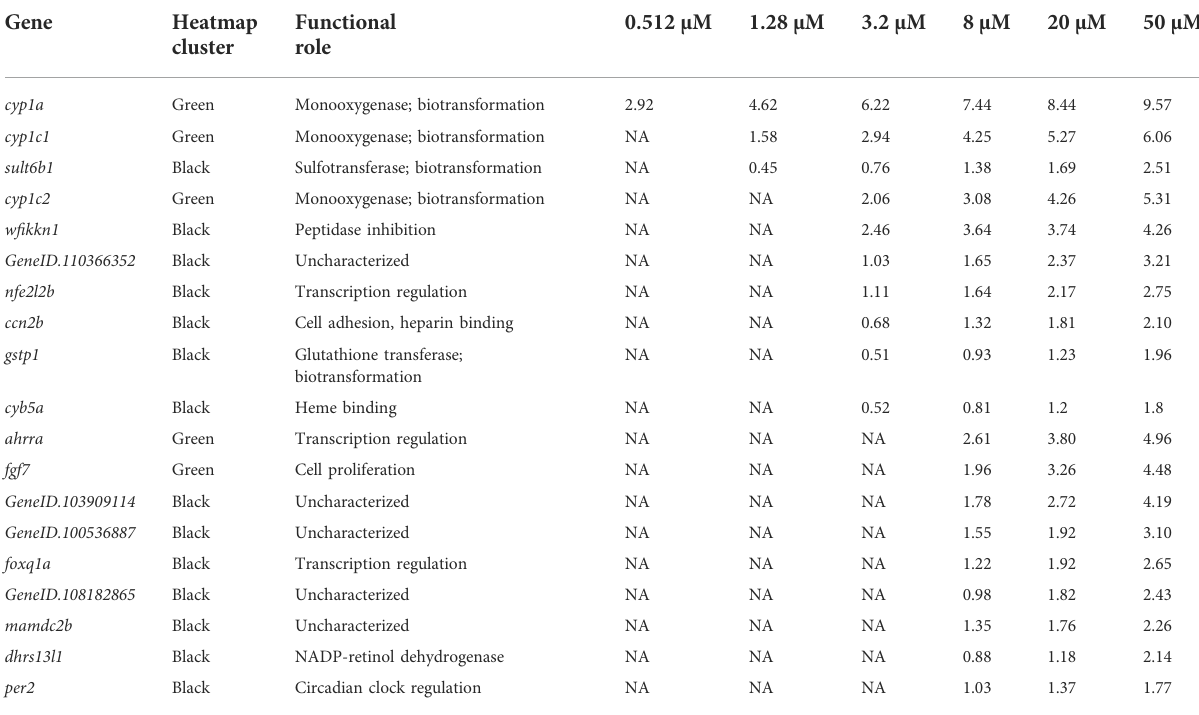
TABLE 2 Black and green heatmap cluster genes which showed the strongest change in expression in response to increasing retene concentration. Log2foldchangevaluesareshown foranygenewithanadjusted p value < 0.05.NA=adjusted p